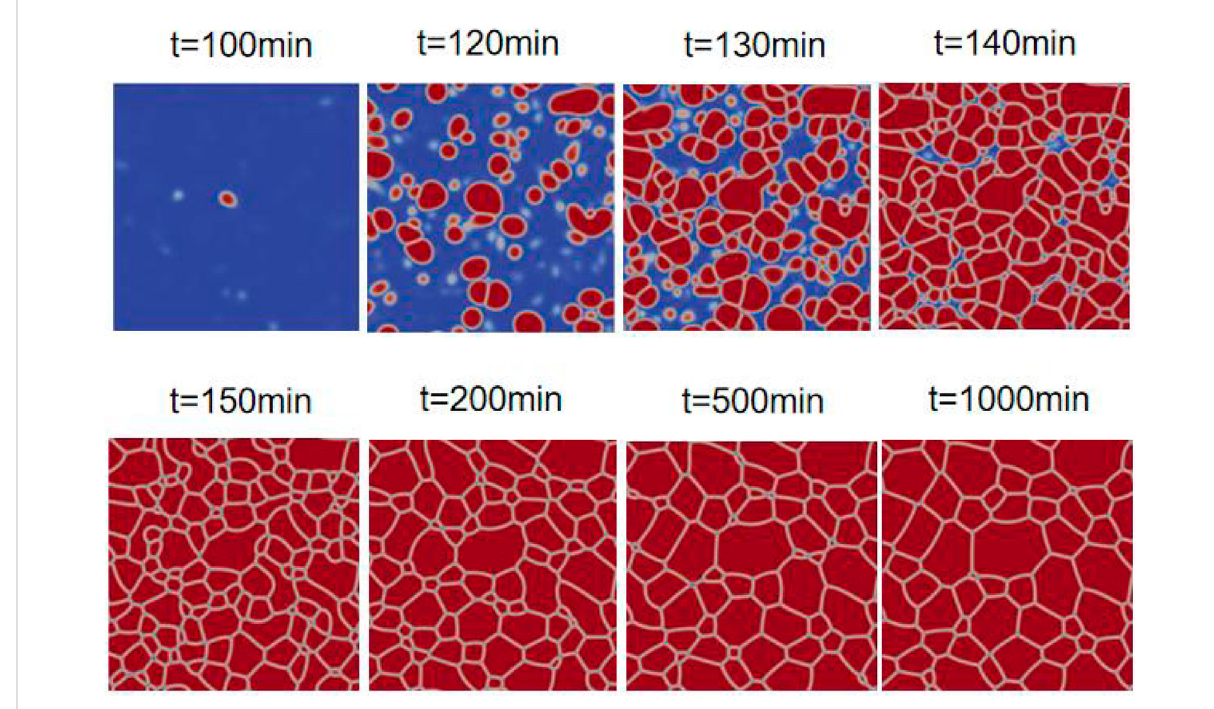
FIGURE 1 Typical scenario of the system evolution with N = 256, L = 2.739 µm, and T = 600 K, at various timesteps